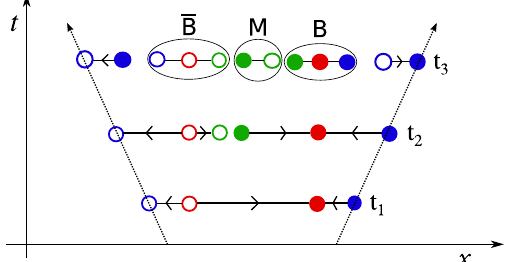
Fig. 2 Illustrationofthepopcorn modelwithastringspannedbetween ablueandanantibluecharge.At t 1 ared-antired q ¯ q pairisproducedasa virtualfluctuation.Inthegreenfieldbetweenthenatwogreen-antigreen pairs are produced at t 2 and t 3 . At t 3 also two new blue-antiblue pairs have been produced closer to the original blue and antiblue charges. The result is a baryon-antibaryon pair with a meson in between